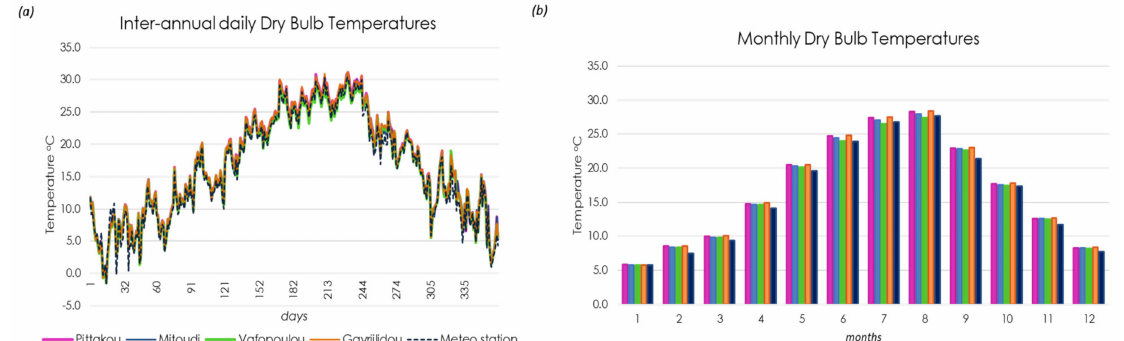
Figure 8. ( a ) Inter-annual daily dry bulb temperatures and ( b ) the mean monthly values of Tair for the urban specific weather datasets corresponding at the 1st floor building units inside the four urban canyons and the reference weather dataset over a typical